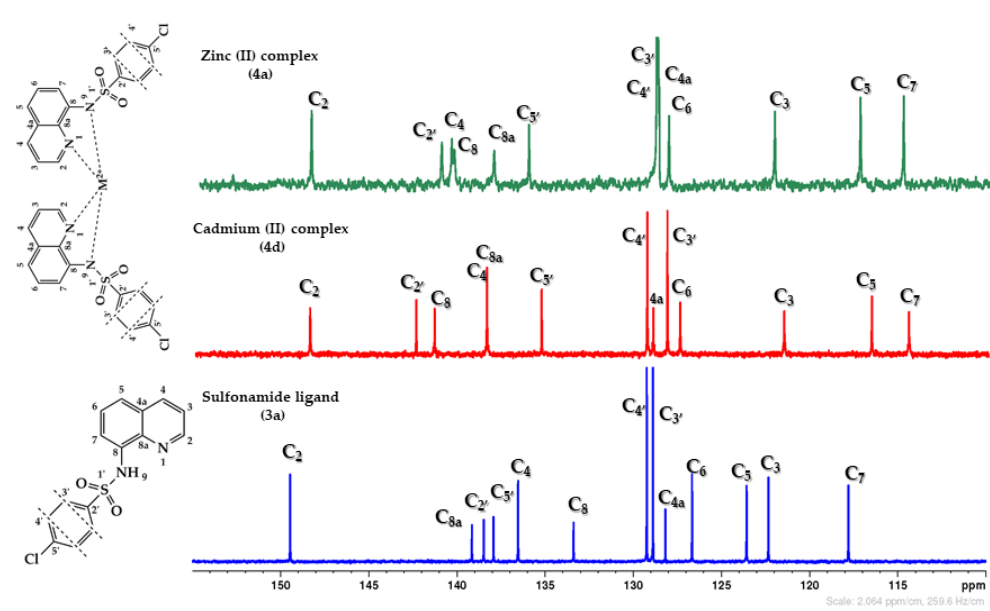
Figure 3. 13 C{ 1 H}-NMR spectra detail (110–160 ppm) for sulfonamide ligand ( 3a ), Zn (II) and Cd (II) complexes.